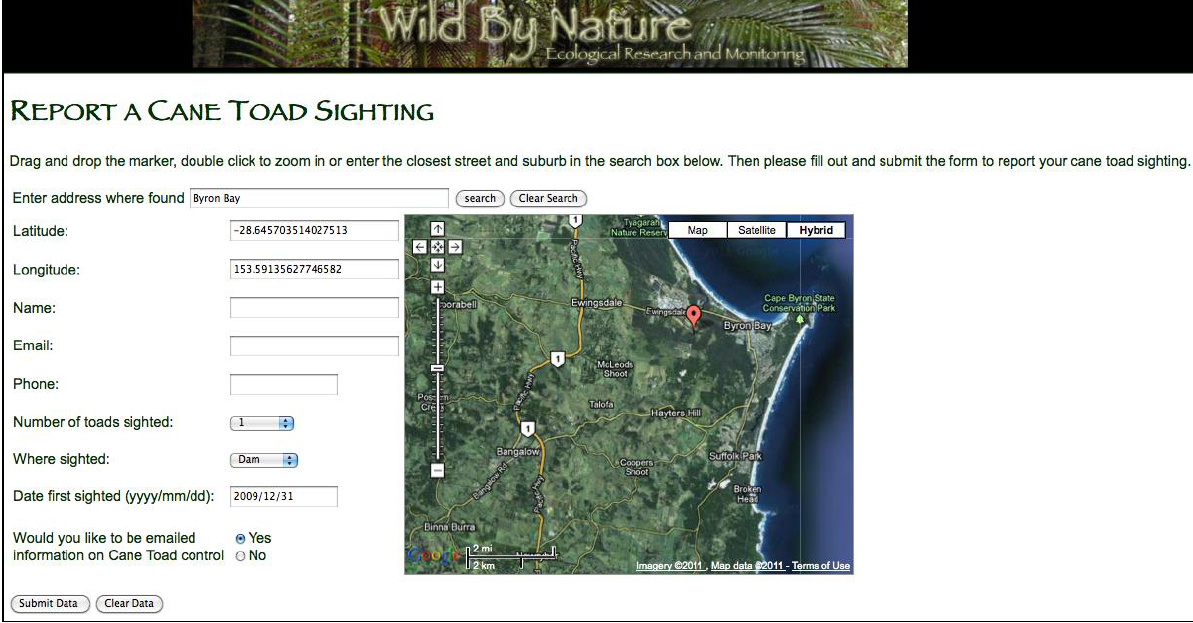
Figure 3. A screen shot of the Toad Tracker